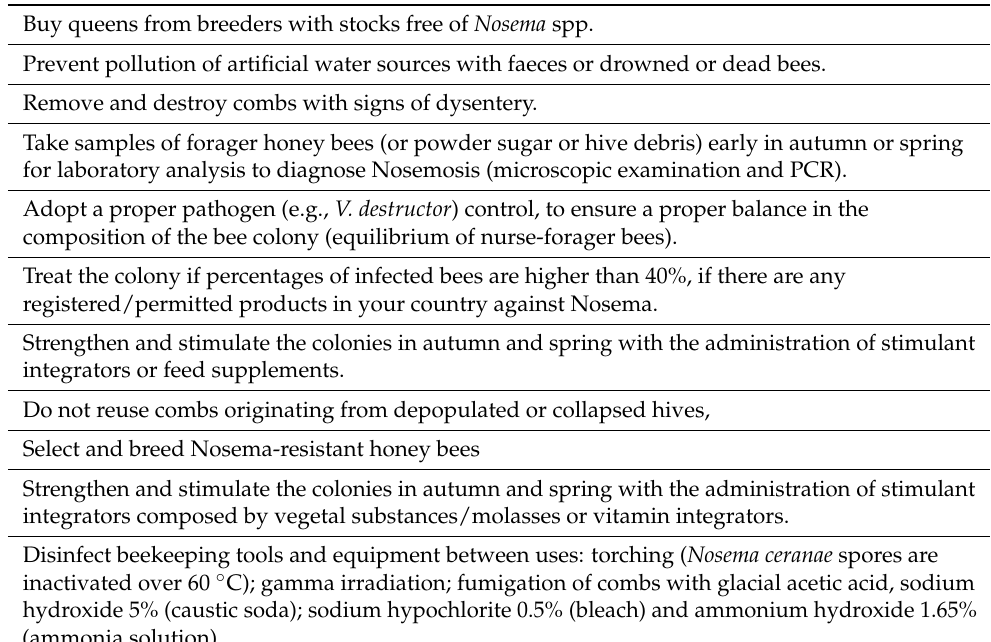
Table 1. Good Beekeeping Practices (GBPs) and Biosafety Measures in Beekeeping (BMBs) for Nosema